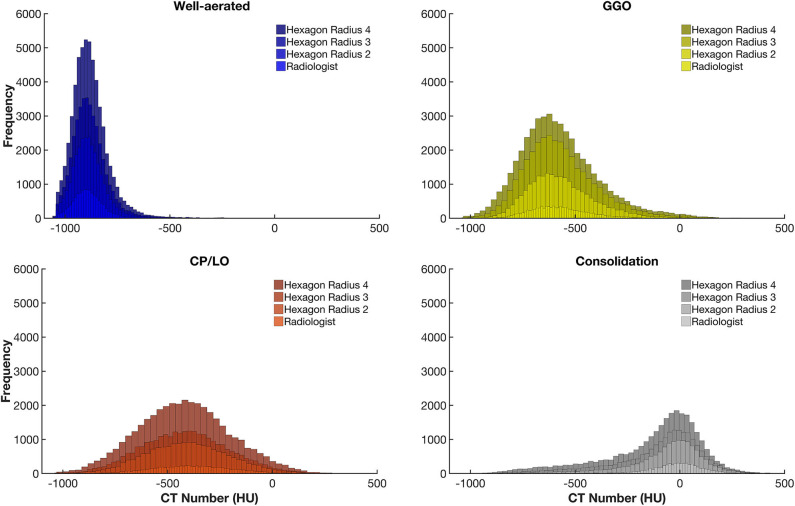
Frequency histograms of the densities expressed in Hounsfield units from all regions of interest visually assigned as well-aerated regions (colored in blue), ground glass opacities (GGO, yellow), crazy paving and linear opacities (CP/LO, orange), and consolidation (light gray). Note that, with the increase in the radius of the regular hexagon, there is an increase in the number of voxels and that, although there is no significant change in the average density values, there is an important increase in the dispersion of voxel densities. This appears to contribute to a reduction in the artificial neural network classifier performance.